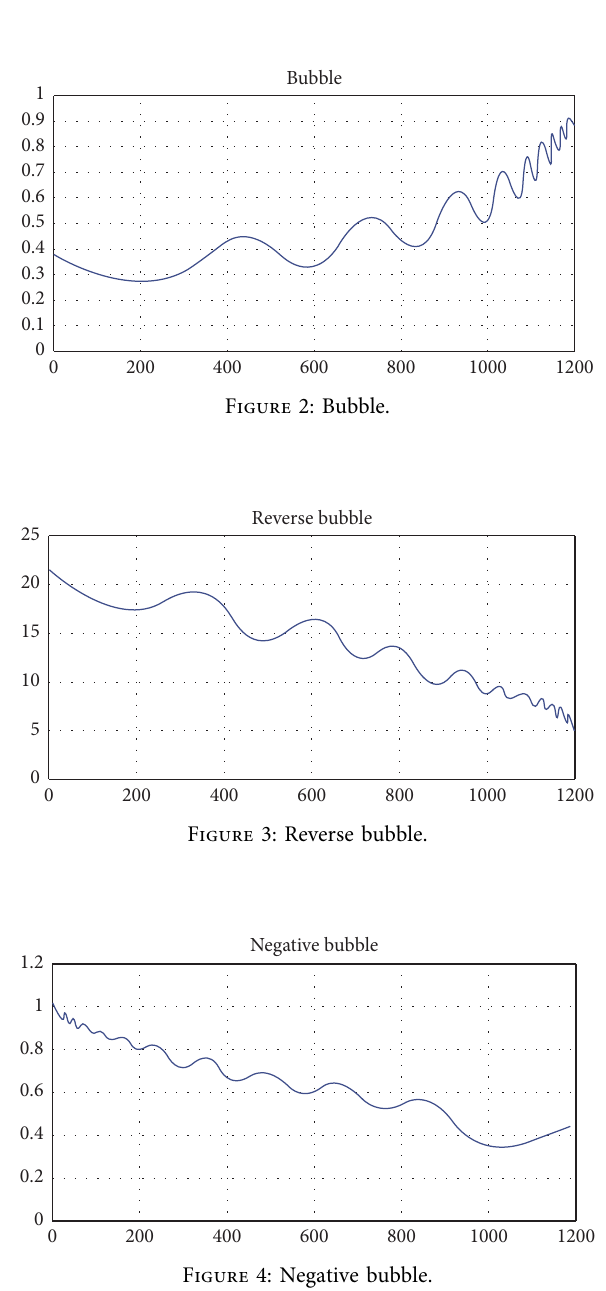
Figure 1: The full risk cycle formed by the feedback mechanism.